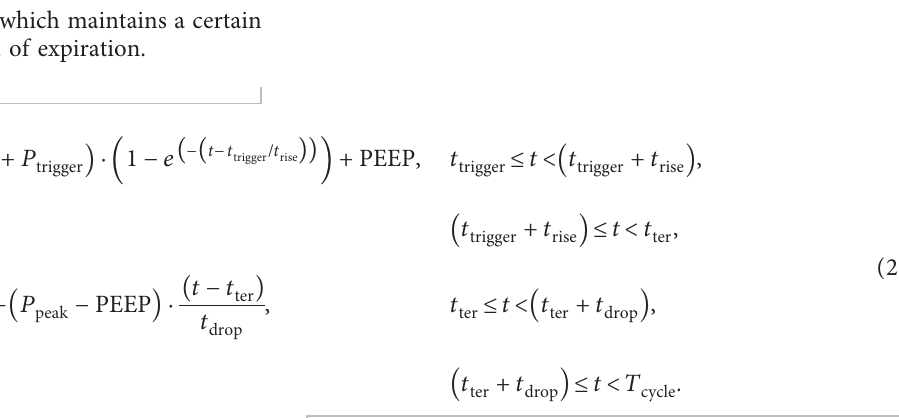
Figure 2: Curve of the pressure changes produced by respiratory muscle. The point m represents P fitted curve; and the red dotted line represents the pressure changes curve produced by the lung